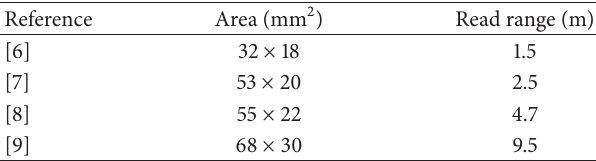
Table 1: Size and read range for different metal tags that can be found in literature (EIRP: 4 W).